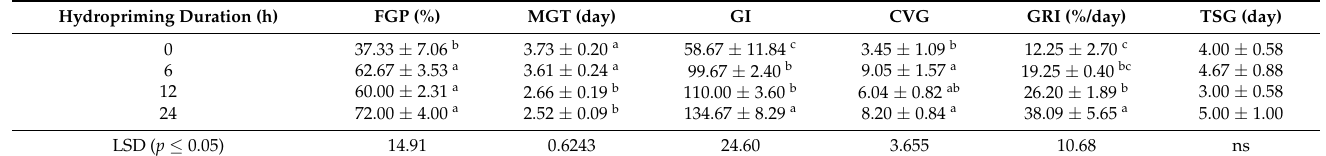
Table 1. Effect of hydropriming duration on Abelmoschus esculentus (genotype VI037996) seed germination incubated at 25 ◦ C. FGP, final germination percentage; MGT, mean germination time; GI, germination index; CVG, coefficient of velocity of germination; GRI, germination rate index; TSG, time spread of germination. In each column, values (mean ± standard error) followed by different letters indicate statistically significant ( p ≤ 0.05) differences. ns, not significant. Hydropriming Duration (h)